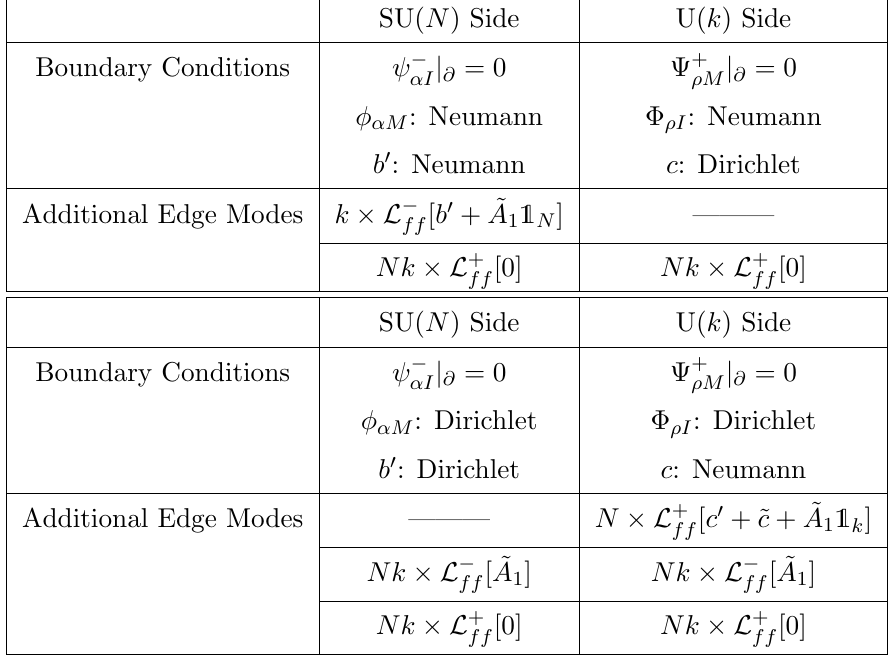
Table 4 . The top (bottom) table counts the additional edge modes when choosing Neumann and Dirichlet boundary conditions on the dynamical gauge (cid:12)elds in SU (U) and U (SU) side respectively when N f 6 = 0 and N s 6 =